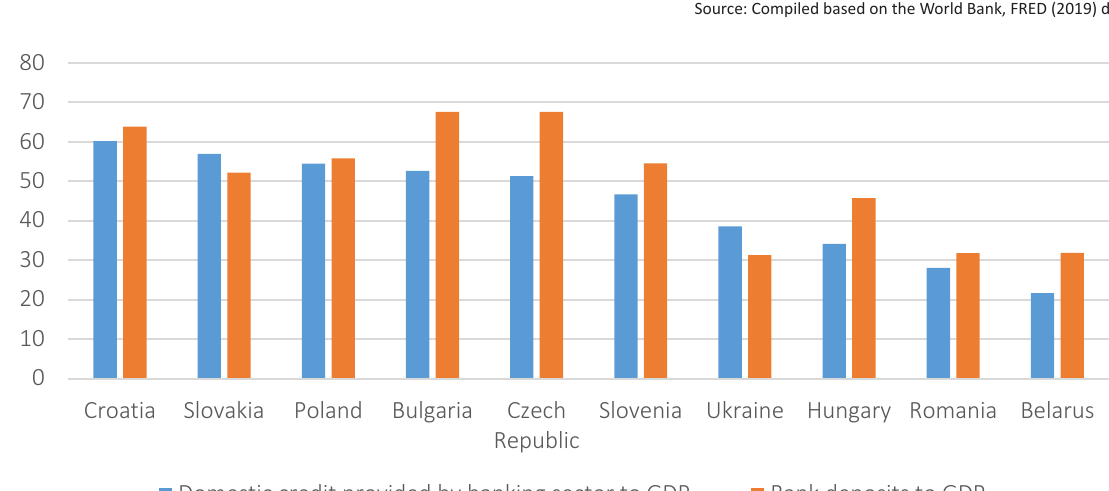
Figure 12. Banking sector penetration indicators, Ukraine and peers, 2016,